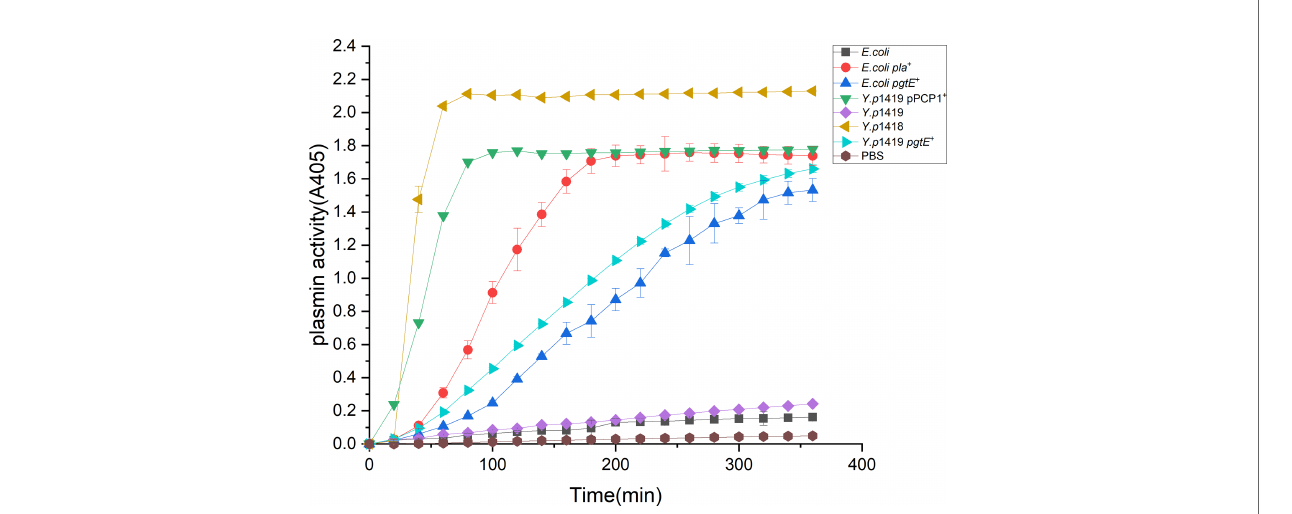
FIGURE 1 | PgtE in recombinant Y. pestis activates plasminogen to plasmin. The plasminogen activation activities of Y.p 1419 pPCP1 + , Y.p 1419, Y.p 1419 pgtE + and E.coli, E.coli pla + were compared. Y.p 1418 was used as a positive control. PBS was used as negative control. The data presented were pooled from three independent